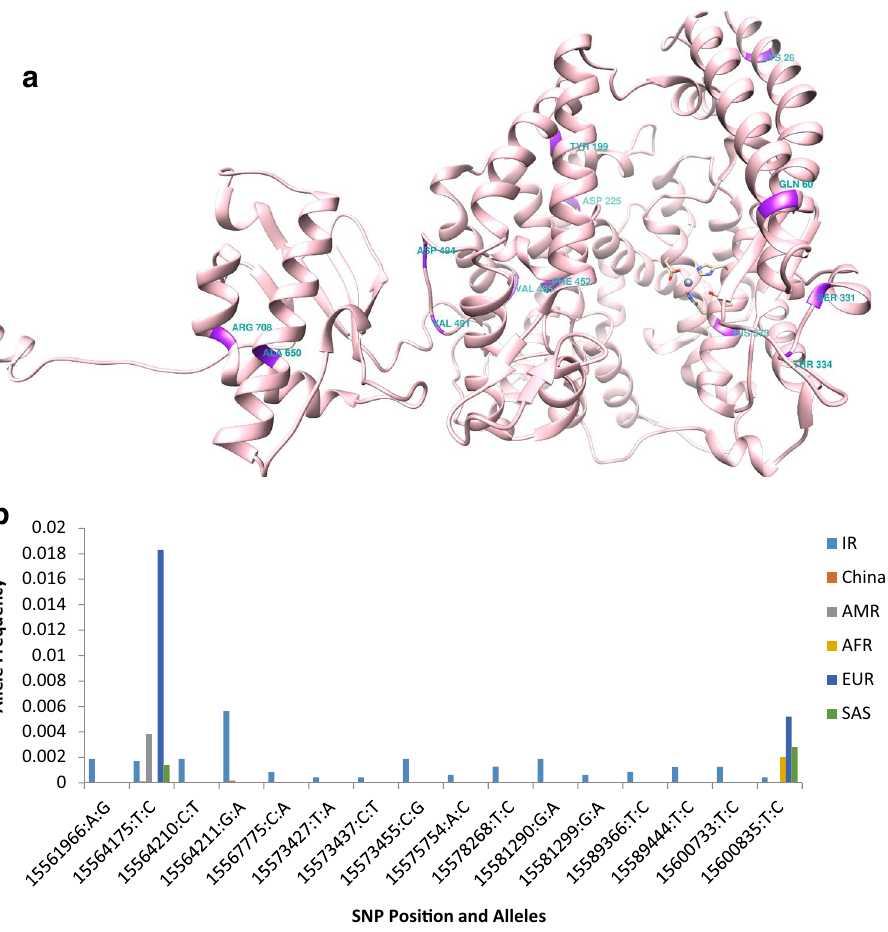
Figure 2. ( a ) The position of missense variants on the 3D structure of ACE2 receptor. The residues of 26 and 331 located at the ACE2 binding site to viral Spike protein, the residue 373 is in the vicinity of the zinc ion binding residues, and residues of 708 and 650 are in the binding site of the ACE2 to TMPRSS2. This figure has been produced by the UCSF Chimera 1.14-linux_x86_64 (https ://www.cgl.ucsf.edu/chime ra/downl oad.html). ( b ) Missense ACE2 variants in Iran, China, and 1000 Genome Project